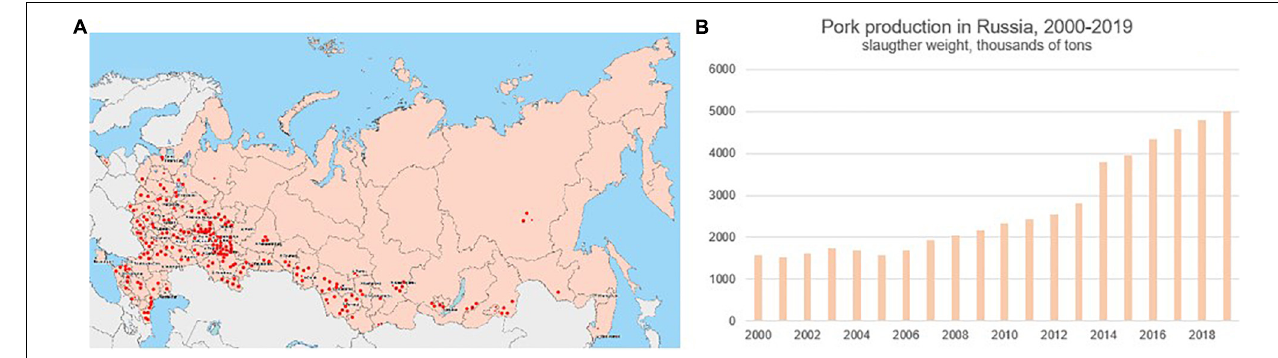
FIGURE 8 | Distribution of swine (pork) production sites in Russia (A) , red dots, and pork production volume in Russia from 2000 to 2019 (B) , according to open data from the National Swine Producers Union (http://www.nssrf.ru/).